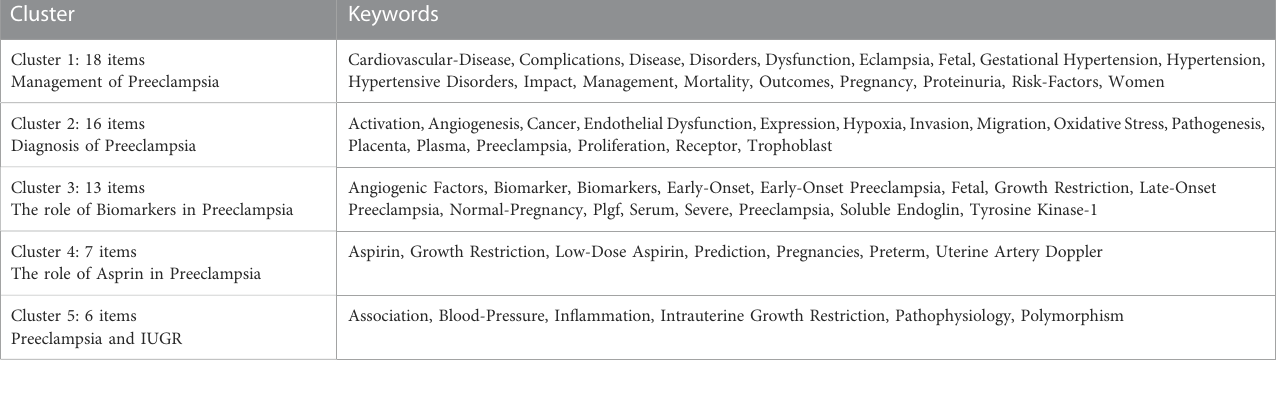
TABLE 3 Classi fi cation of keywords based on clusters. Cluster